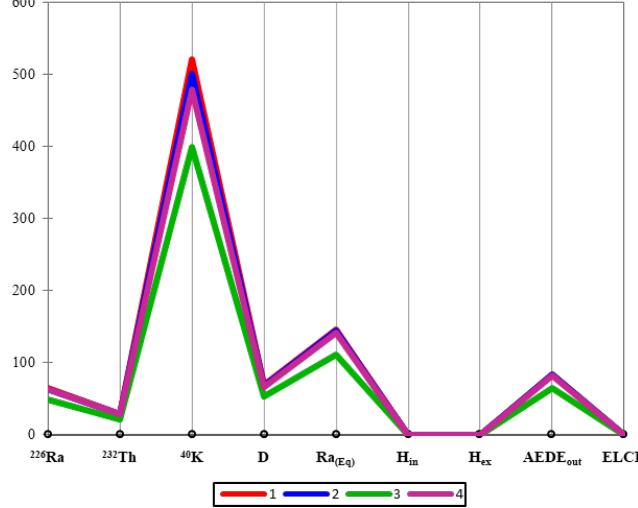
Figure 6. The values of the original variables for the four clusters.